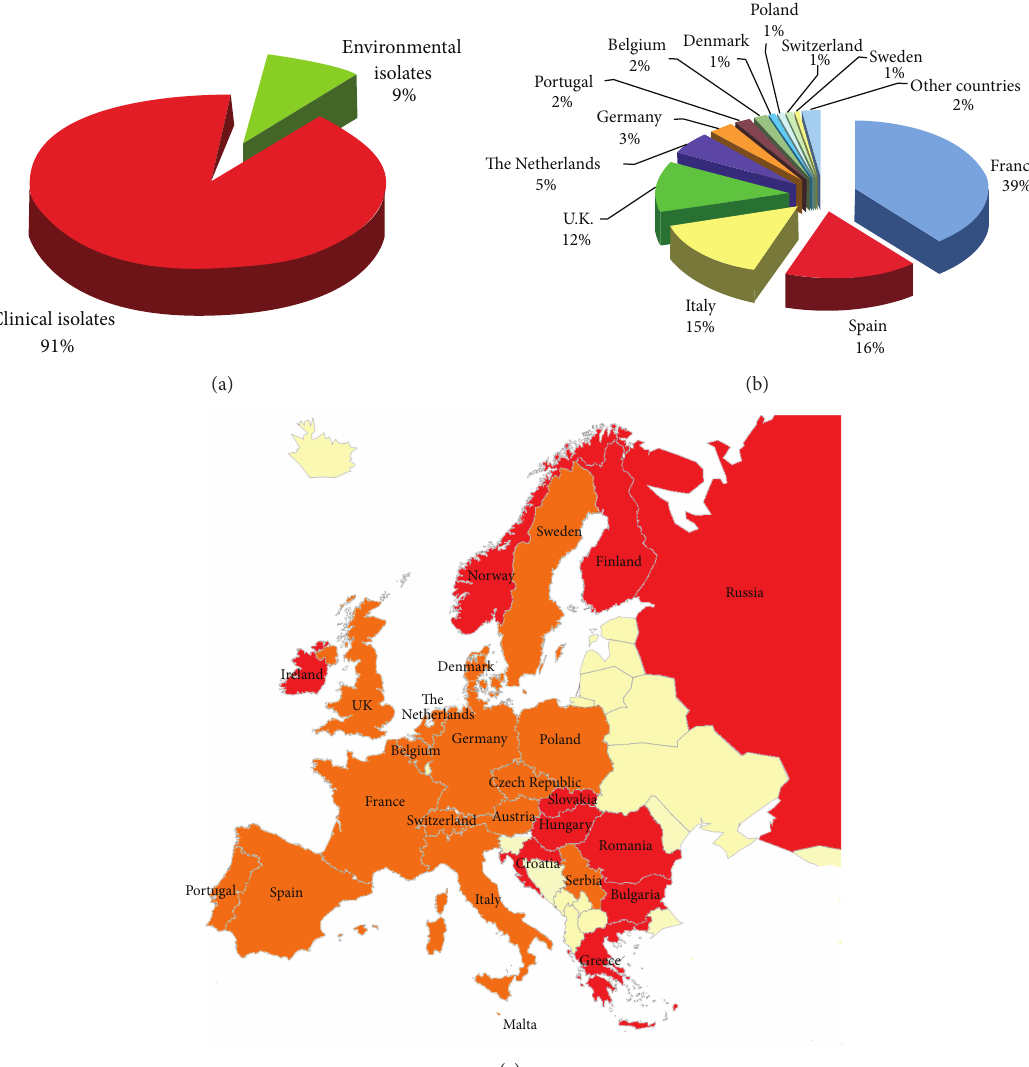
F 7: Percentage of Cryptococcus neoformans and Cryptococcus gattii isolates from clinical ( sources (a). Distribution of Cryptococcus neoformans and Cryptococcus gattii isolates in the different European countries (b). Map of the geographical distribution of the Cryptococcus neoformans and Cryptococcus gattii isolates in Europe (c). Clinical isolates were reported from red-colored countries, whereas both clinical and environmental isolates were reported from orange-colored